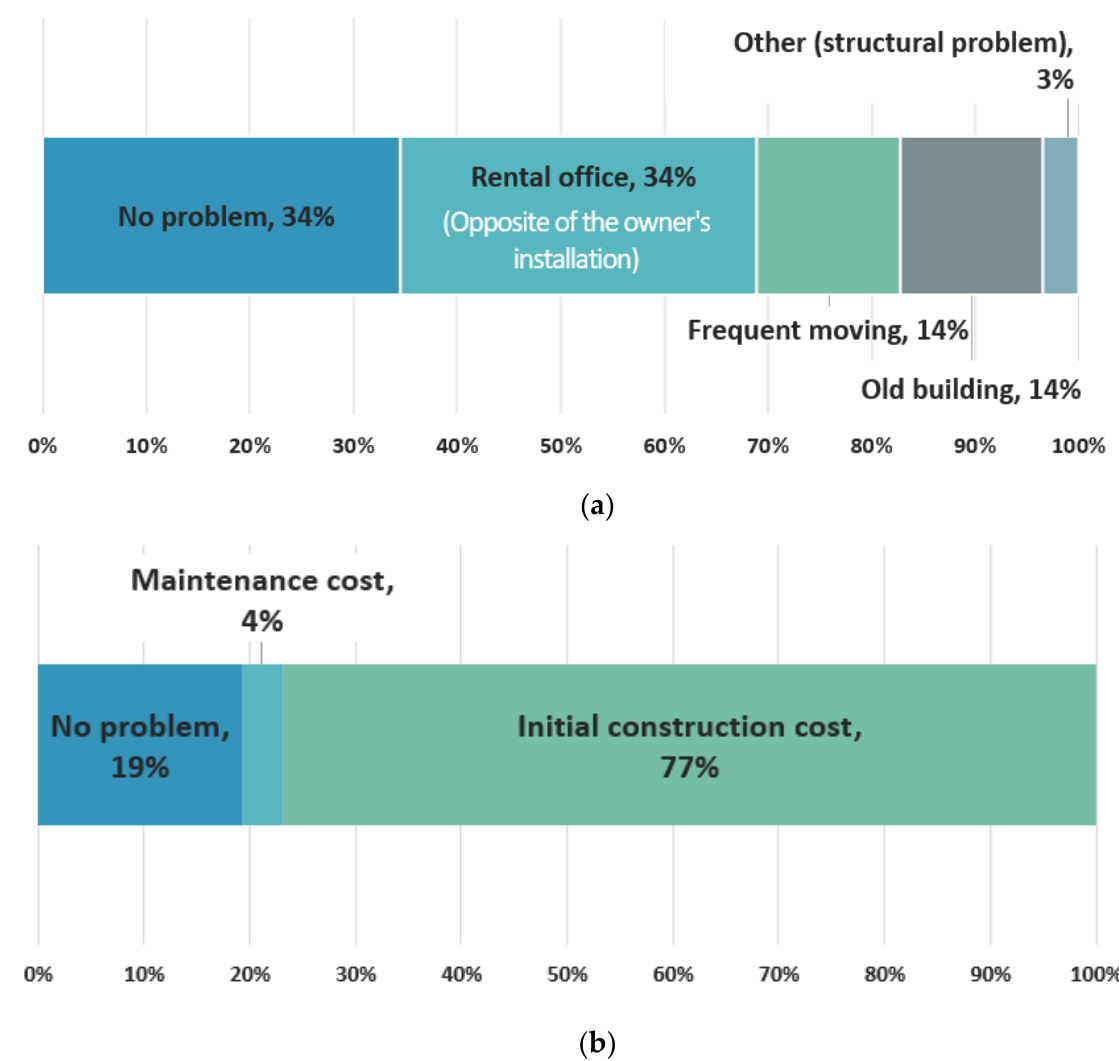
Figure 12. Survey result of office spaces without mechanical ventilation system: concerns when installing mechanical ventilation system regarding ( a ) installation and construction problems and ( b ) economic problems.